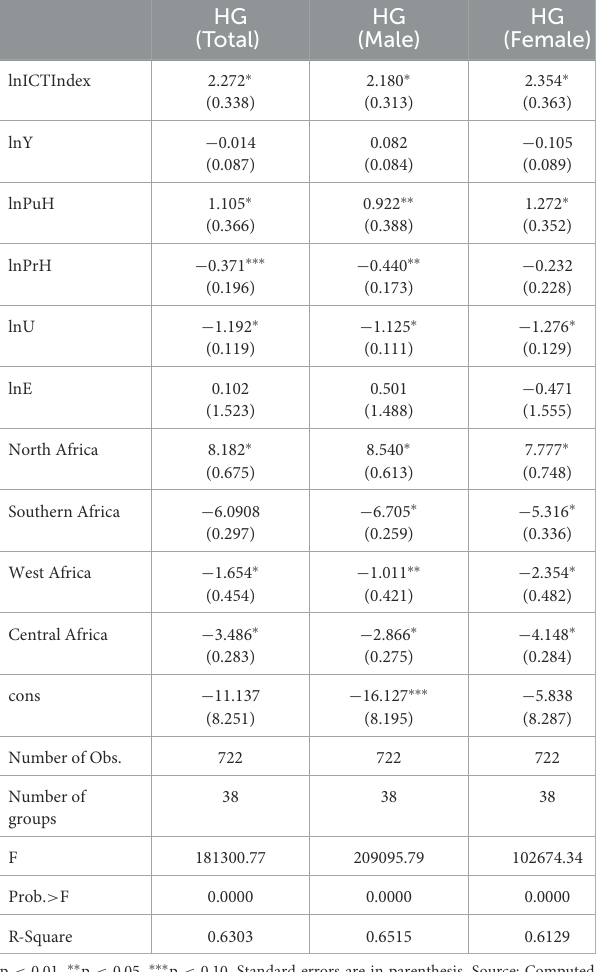
TABLE 5 Estimation results: Driscoll–Kraay standard errors - full sample. TABLE 6 Estimation results: Driscoll–Kraay standard errors: by ICT